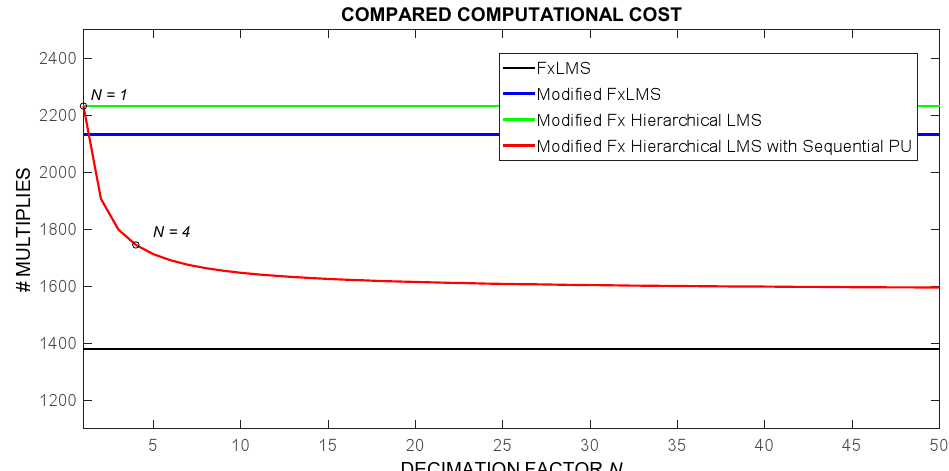
Figure 9. Computational complexities of different ANC algorithms in terms of the average number of multiplications per iteration.